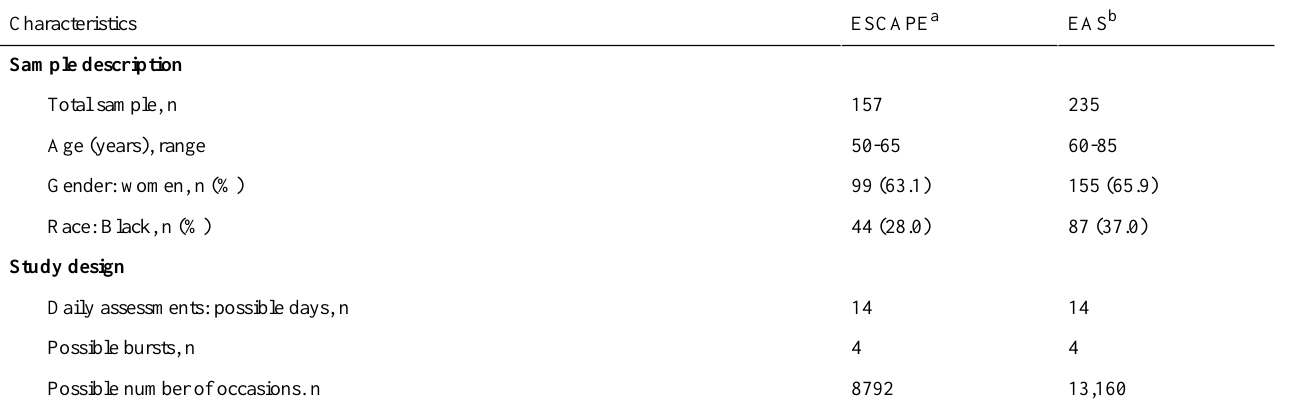
Table 1. Sample and design